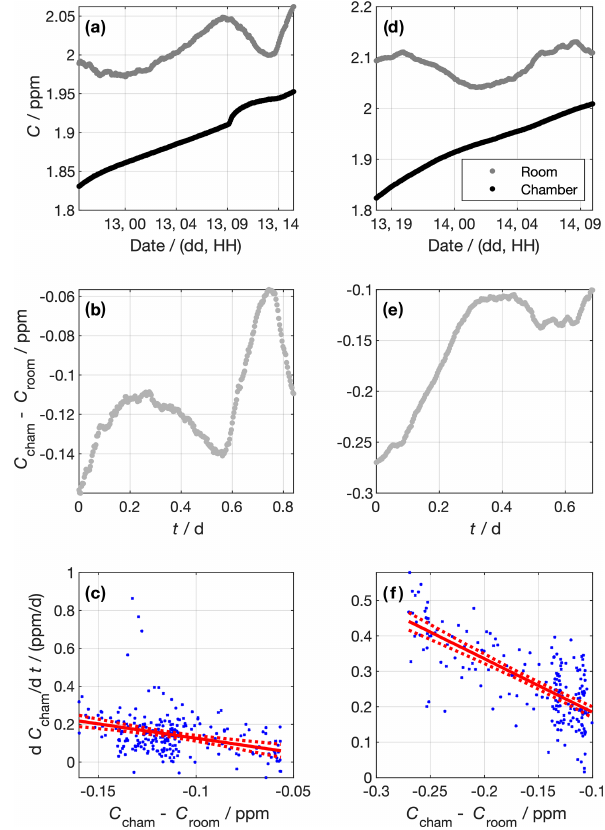
Figure 6. Data from experiments to determine the chamber air ex- change rate. Panels (a) to (c) and (d) to (f) show data from the first and second experiments, respectively. The top panels ( a and d ) show the measured CH 4 concentrations in the chamber and the lab out- side. Panels (b) and (e) show the concentration difference between the chamber and the lab outside. Panels (c) and (f) show the linear regressions constructed using Eq. (5). Blue dots show individual data points. The red lines show the best fit and 95% confidence against C cham − C room . intervals of the linear regression of d C cham d t The gradient of the linear regression corresponds to the air exchange rate coefficient, − k . For the first experiment, k = ( 1 . 5 ± 0 . 3 ) d − 1 , and for the second experiment, k = ( 1 . 5 ± 0 . 1 ) d − 1